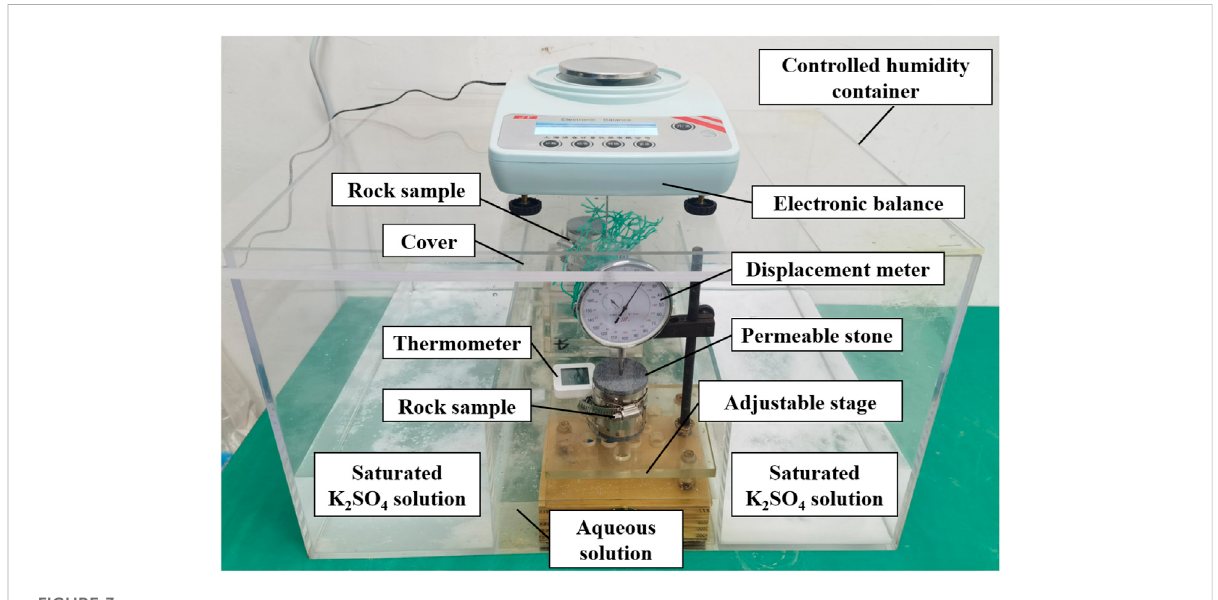
FIGURE 3 Test device for dry-wet deformation of